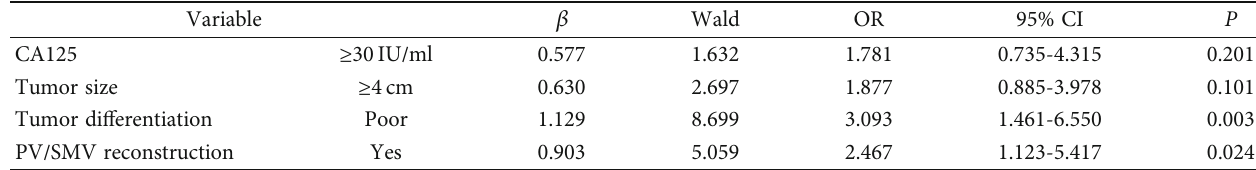
Table 4: Multivariate analysis of risk factors for early liver